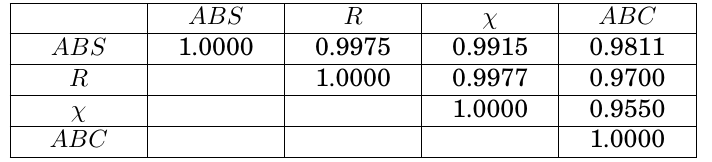
Table 1: The absolute values of the correlation coefficients between some indices.